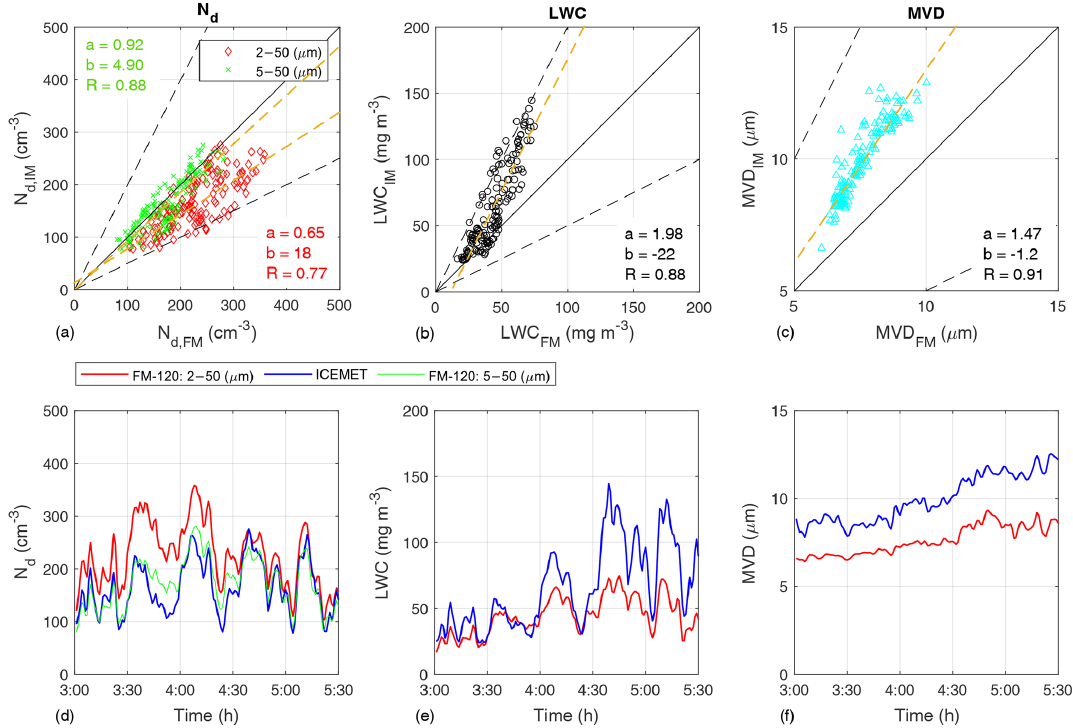
Figure 9. Intercomparison of N d (a,d) , LWC (b,e) , and MVD (c,f) values between ICEMET (subscript IM, blue line), and FM-120 (subscript FM, red markers/line) in the period of isoaxial sampling (cloud event on 2 October 2020). N d , FM was also presented without the lowest bins in the size range of 5–50µm in (a) and (d) , marked as green markers/lines. The dashed orange lines represent linear regression with a = slope, b = intercept, and R = Pearson correlation coefficient. Black lines represent 1 : 1 (solid), 1 : 2 (dashed) and 2 : 1 (dashed)